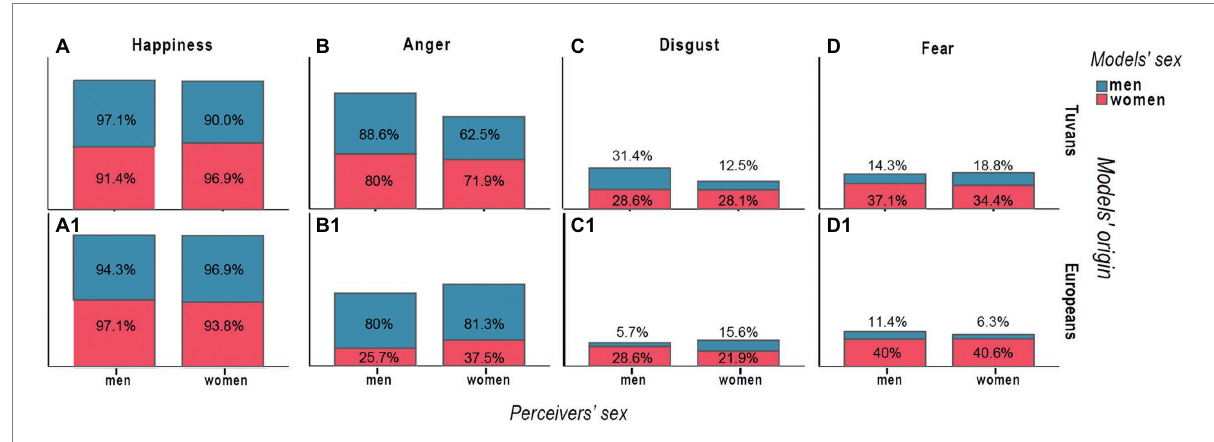
FIGURE 1 Relative frequencies of right guesses, where general number of perceivers of the same sex estimating models of the same sex and origin are taken as